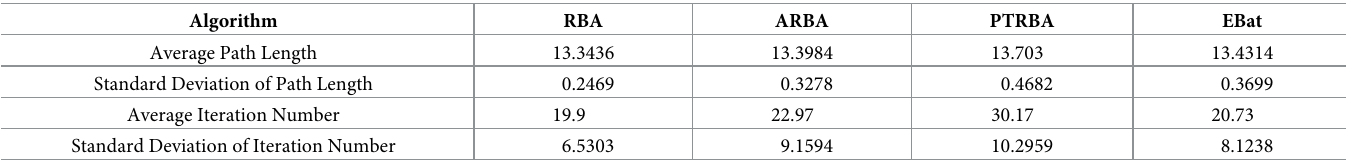
Table 6. Performance comparison between RBA and BA variants in test case